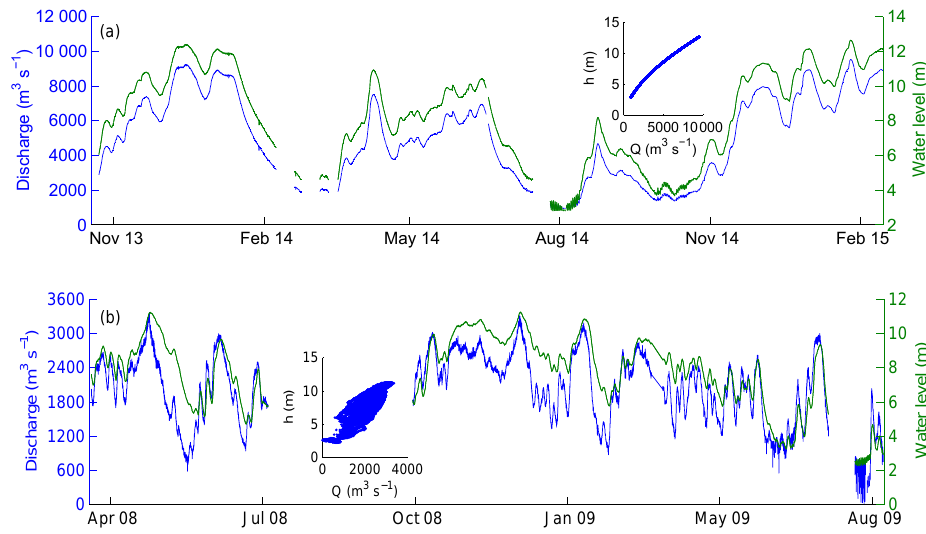
Figure 9. Discharge series from flow monitoring stations of the Kapuas at Sanggau (a) and the Mahakam at Melak (b) with scatter plots showing stage–discharge relations. Water stages are with respect to the pressure gauge